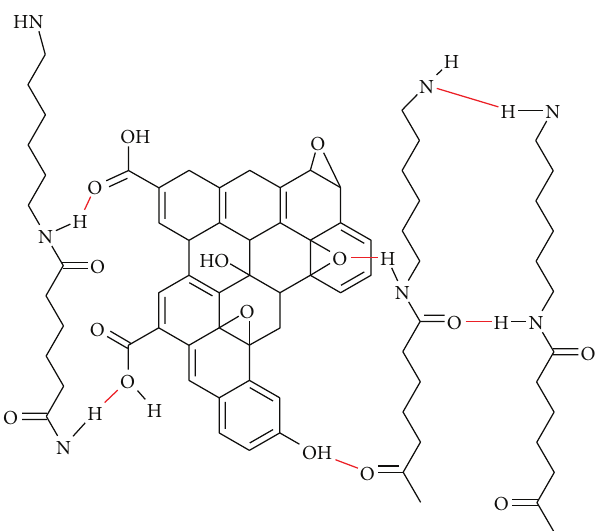
Figure 13: Possible coupling of nylon and FGO through hydrogen bonds and dipole-dipole